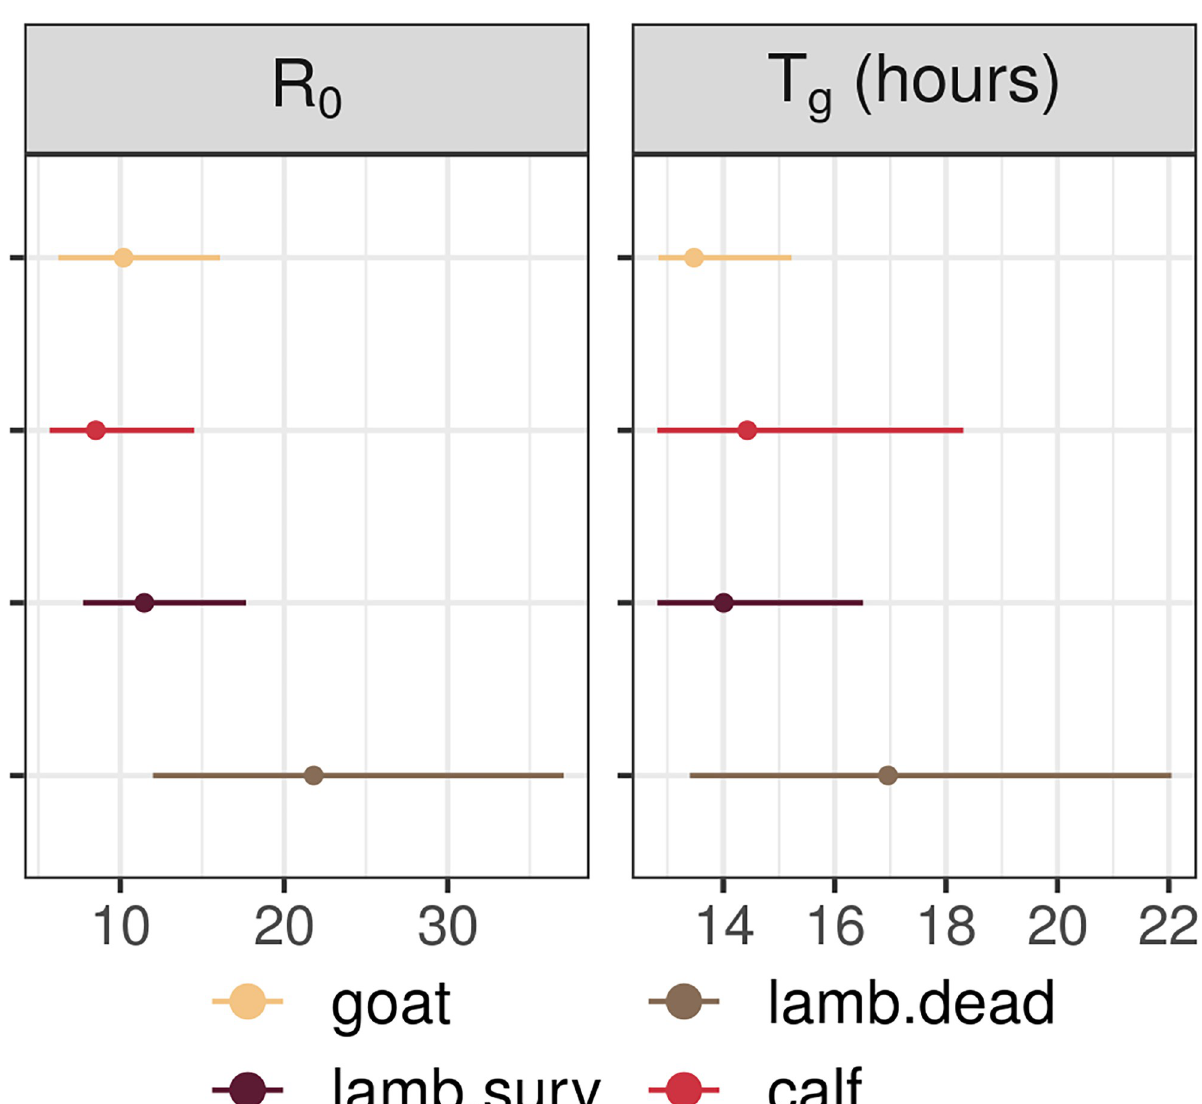
Fig 3. Outcome measures per host group. Points are median estimates, lines show highest density intervals, computed from joint posterior distributions (3 chains). Basic reproduction number R 0 is computed with Eq (3) and generation time T constrained in their lower values due to the eclipse phase duration ( κ − 1 ) and rate of virus entry into cells ( β ) being fixed (Table 1).